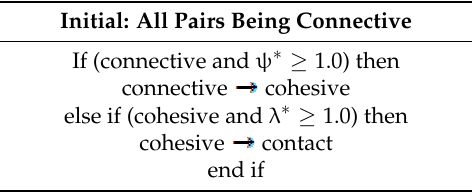
Table 1. Transition procedures for discrete element (DE) particle pairs. Initial: All Pairs Being Connective If (connective and ψ ∗ ≥ 1.0) then